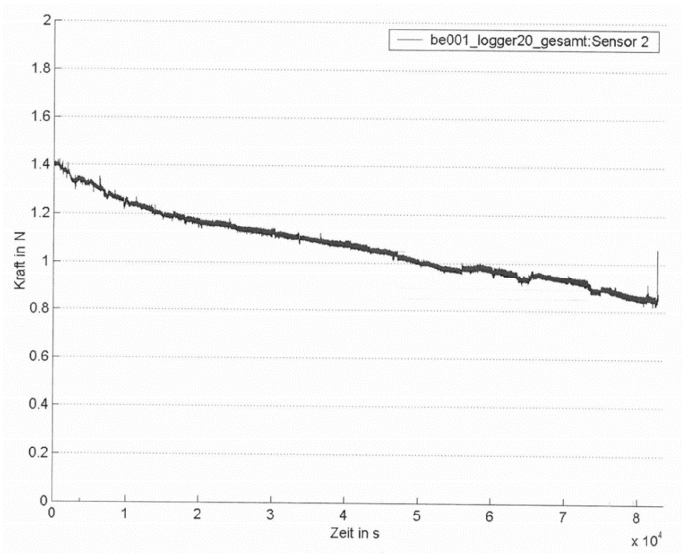
Figure 4. Example of an individual suture tension diagram after laparotomy closure without elevation of intra-abdominal pressure. Total recording time: 23.3 h (8.4 × 10 4 s) ( x -axis label: time in s; y -axis label: force in N).